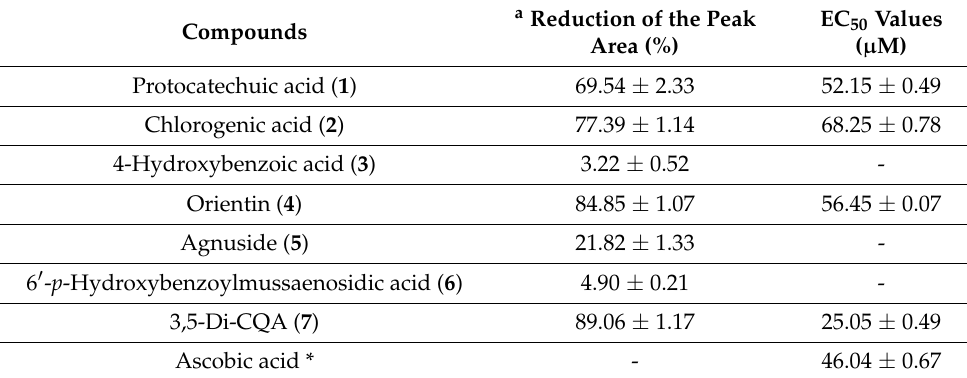
Table 4. Antioxidant effect of seven marker compounds on DPPH radical.